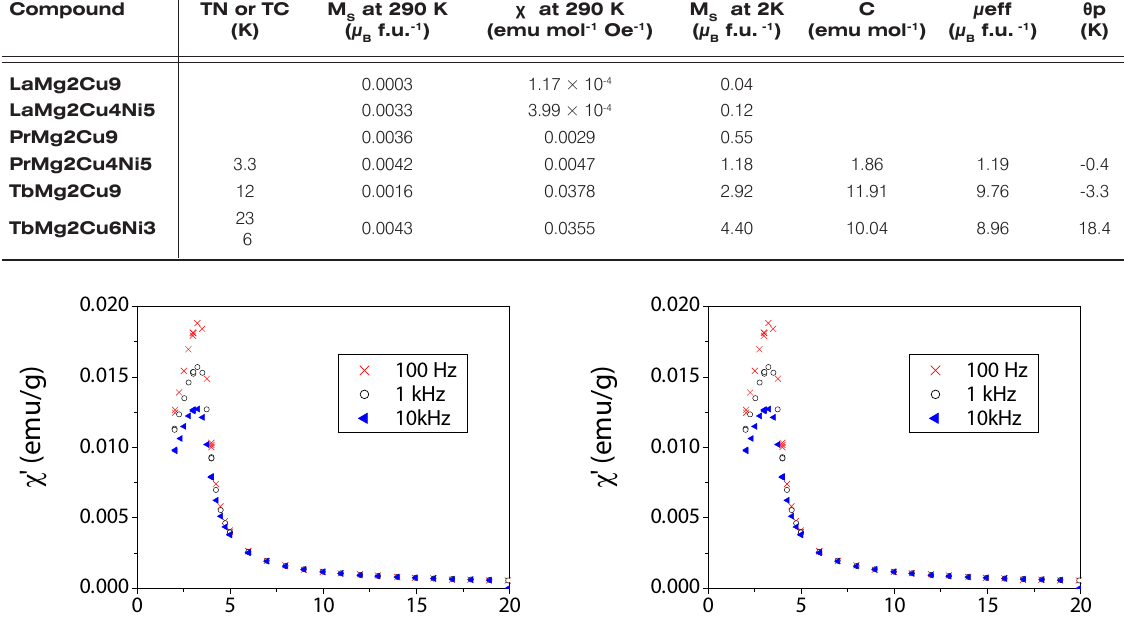
Figure 6. AC susceptibility of PrMg